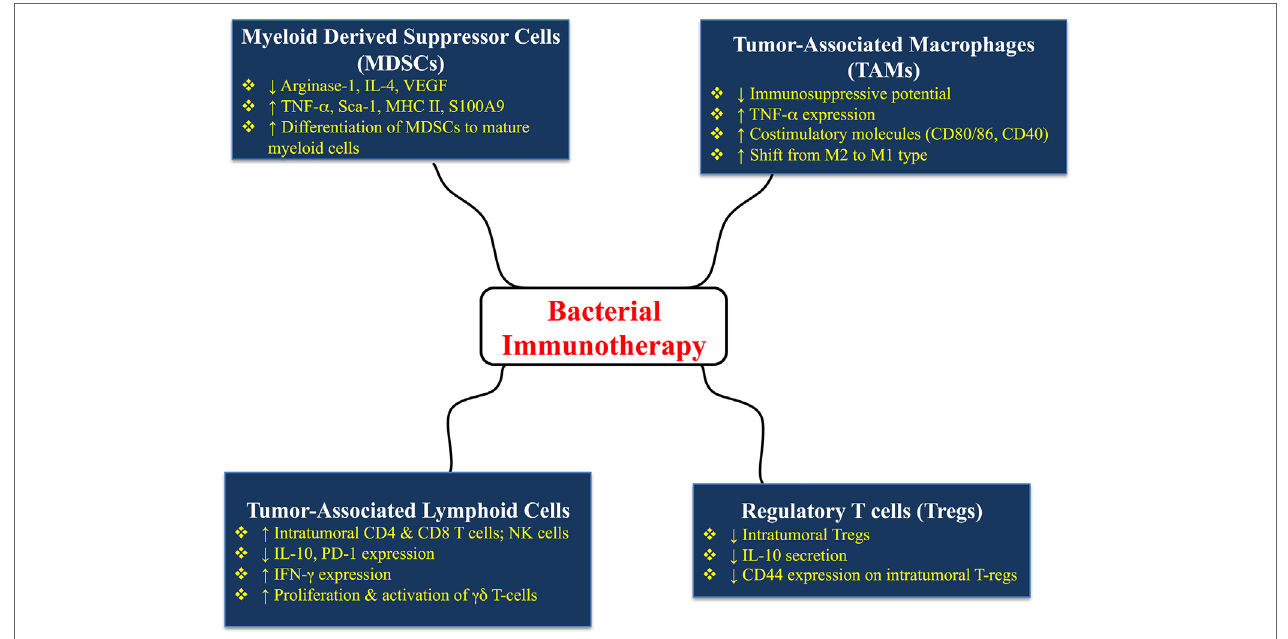
FiGUre 2 | Multiple effects of bacterial immunotherapy on different immune cell types in tumor-bearing hosts. The details and references for the summarized changes are discussed in the